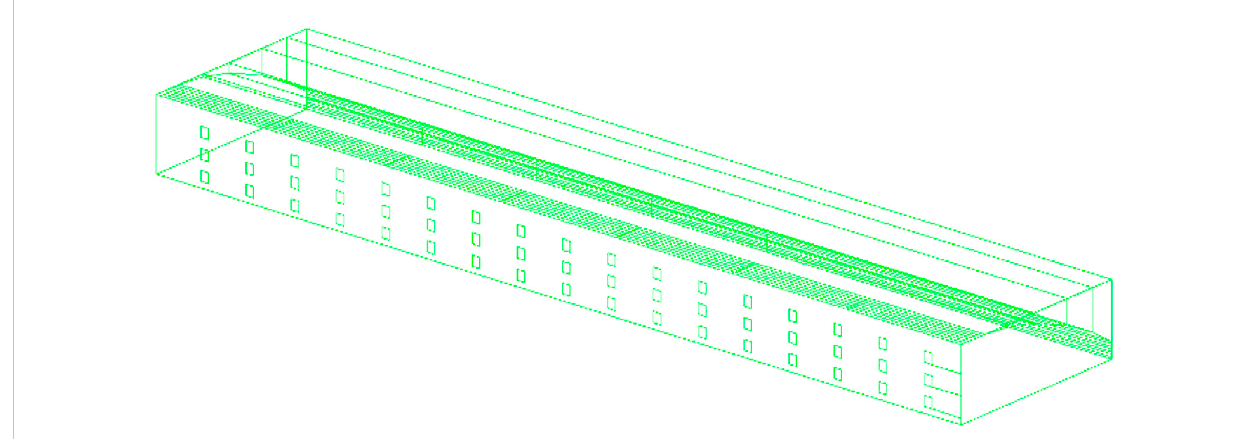
FIGURE 4 Schematic diagram of greenhouse tuyere layout.